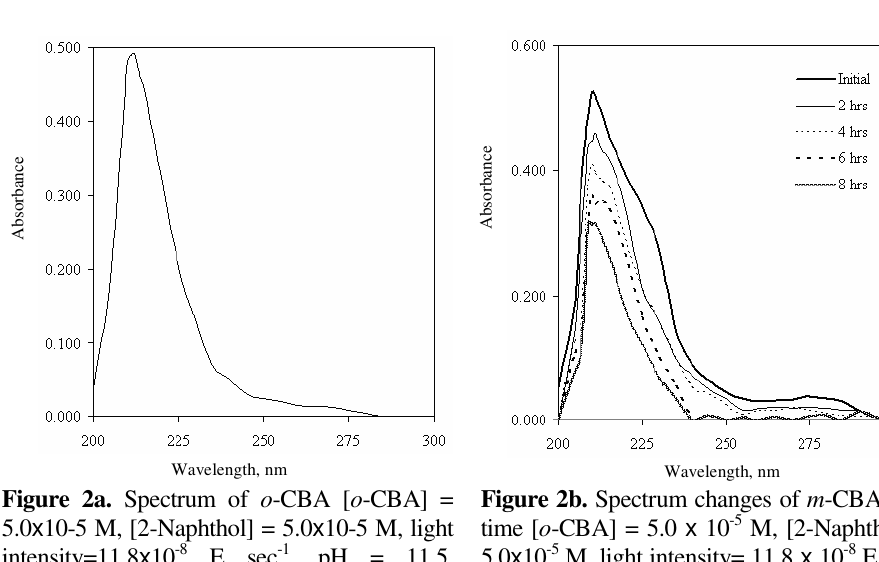
Figure 2c. Spectrum changes of p -CBA with time [ o -CBA] = 4.0 x 10-5 M, [2-Naphthol] = 5.0 x 10 -5 M, light intensity= 11.8 x 10 -8 E sec -1 , pH = 11.5, Temperature = 298 K